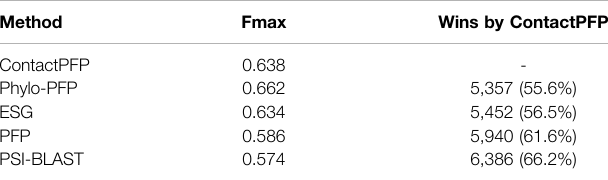
TABLE1| TheaverageFmaxscoreofContactPFPandtheotherfourmethodson the benchmark dataset.